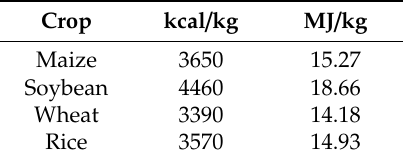
Table 2. Energy densities per selected